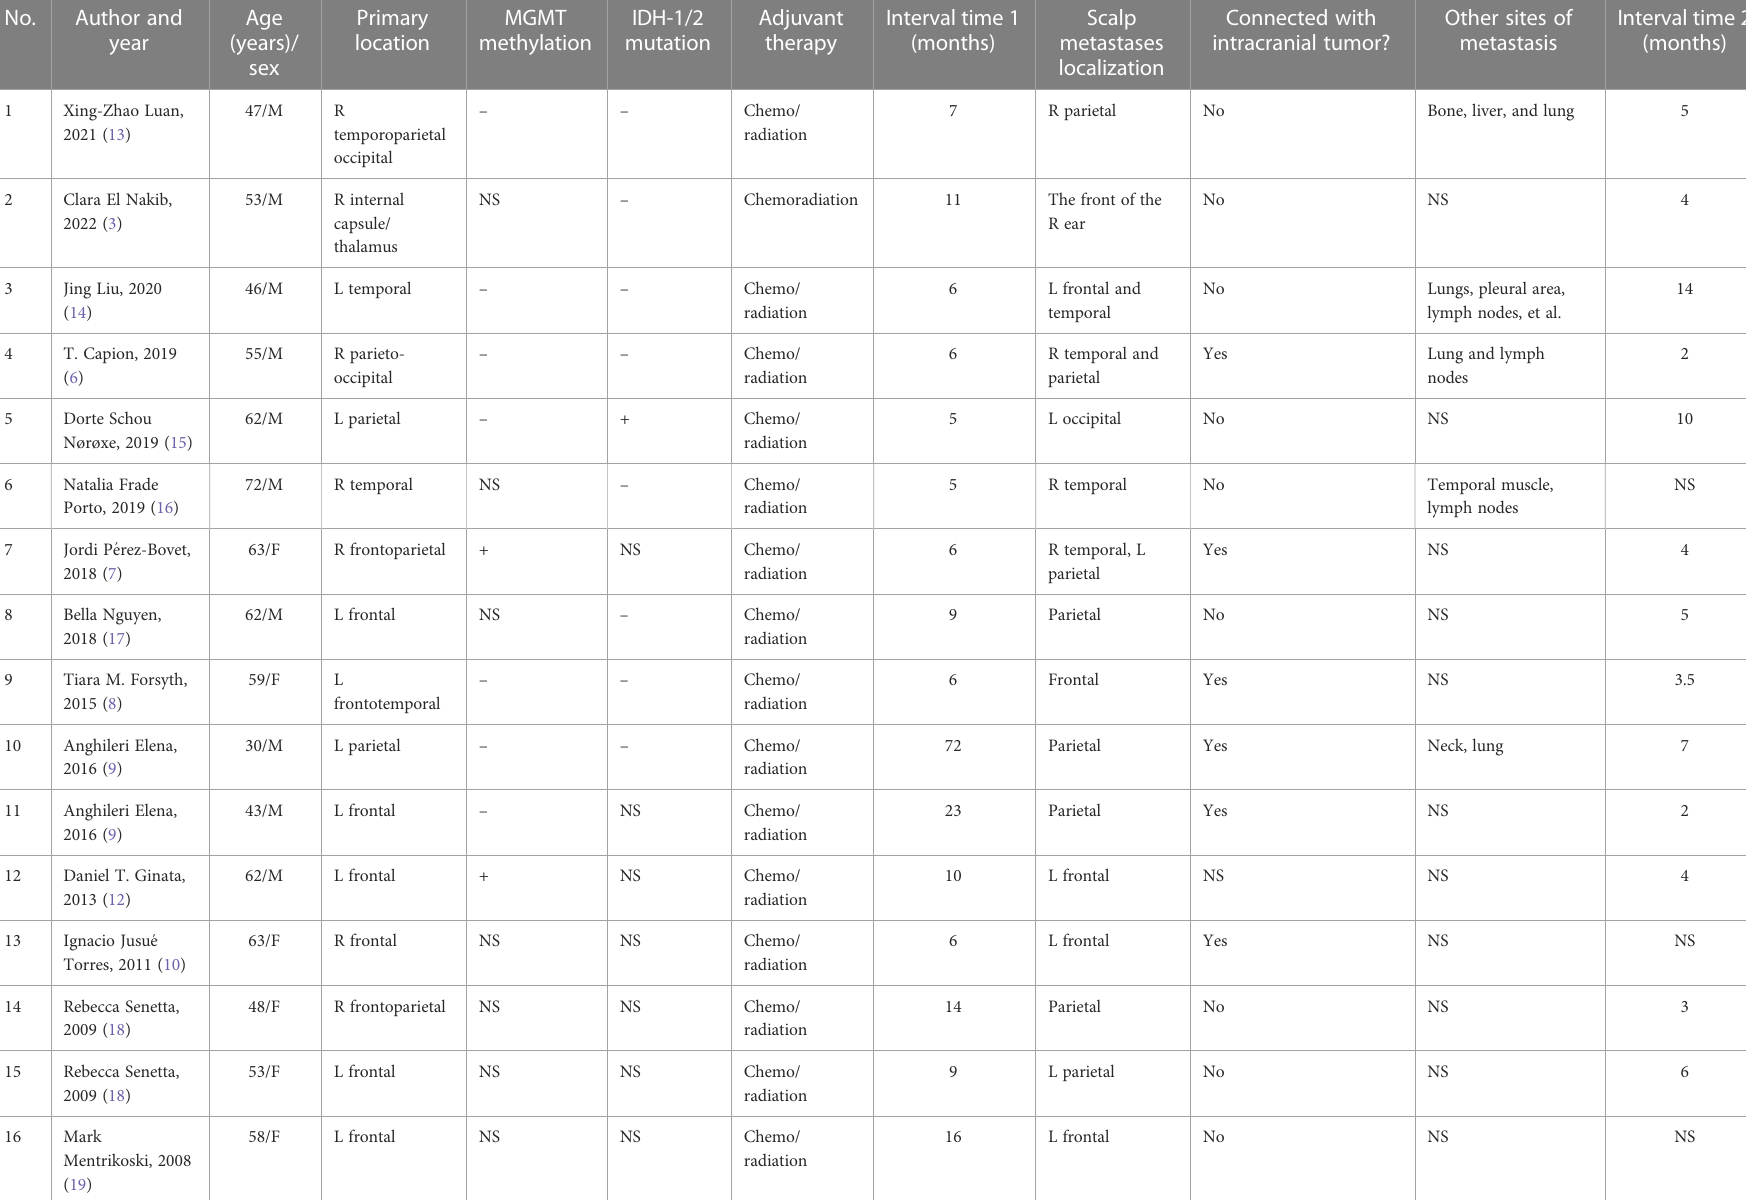
TABLE 1 Review from the literatures of 24 reported GBM with scalp metastases.